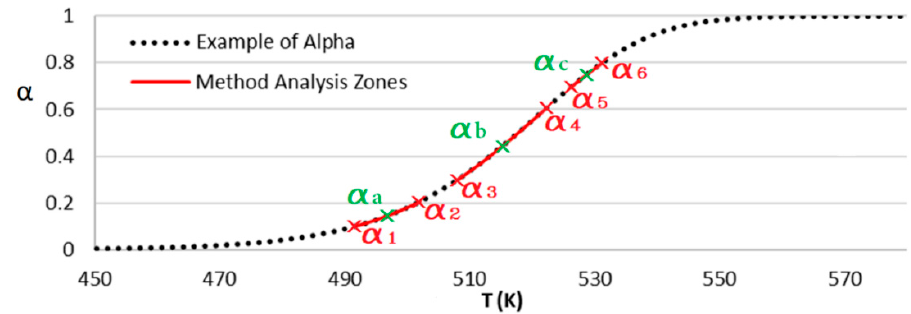
Figure 2. Location of α intervals for reaction order determination.